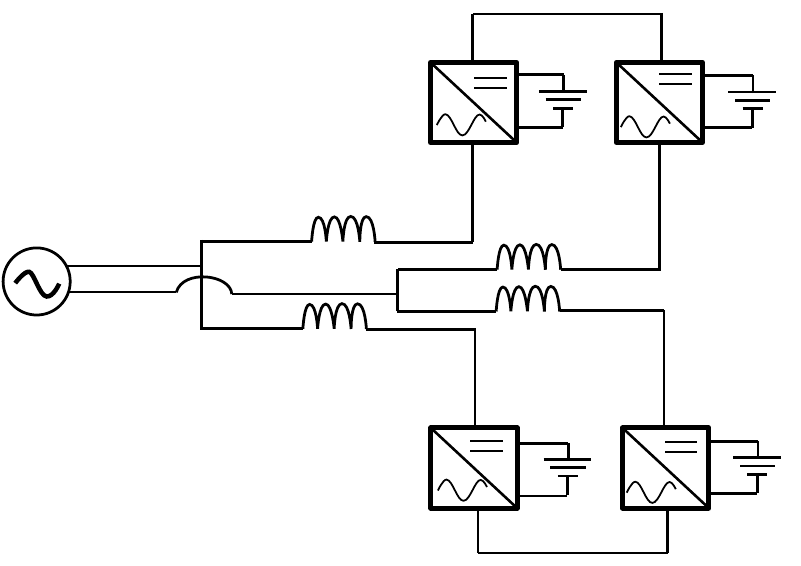
Figure 2. Modular Multilevel Charger